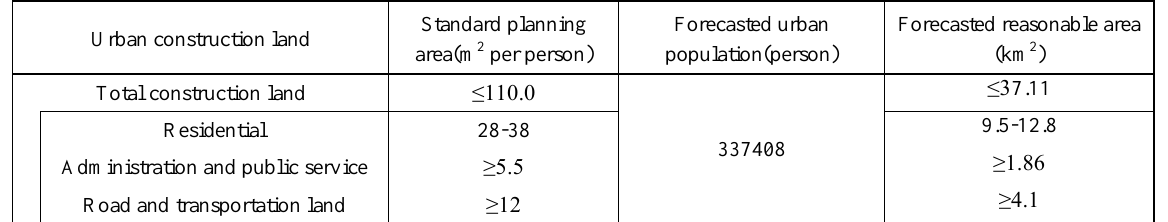
(Table 6.), according to the national standard of "Code for classification of urban land use and planning standards of development land (GB50137-2011)", considering ChengMai as belonging to the fourth climate